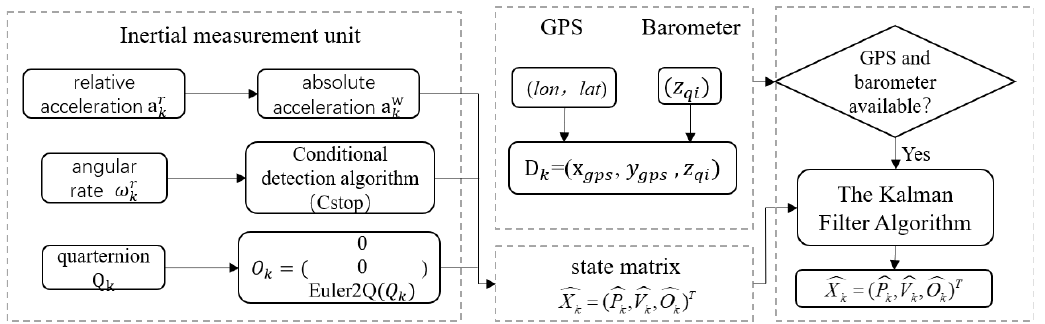
Figure 4. Fusion positioning algorithm architecture.